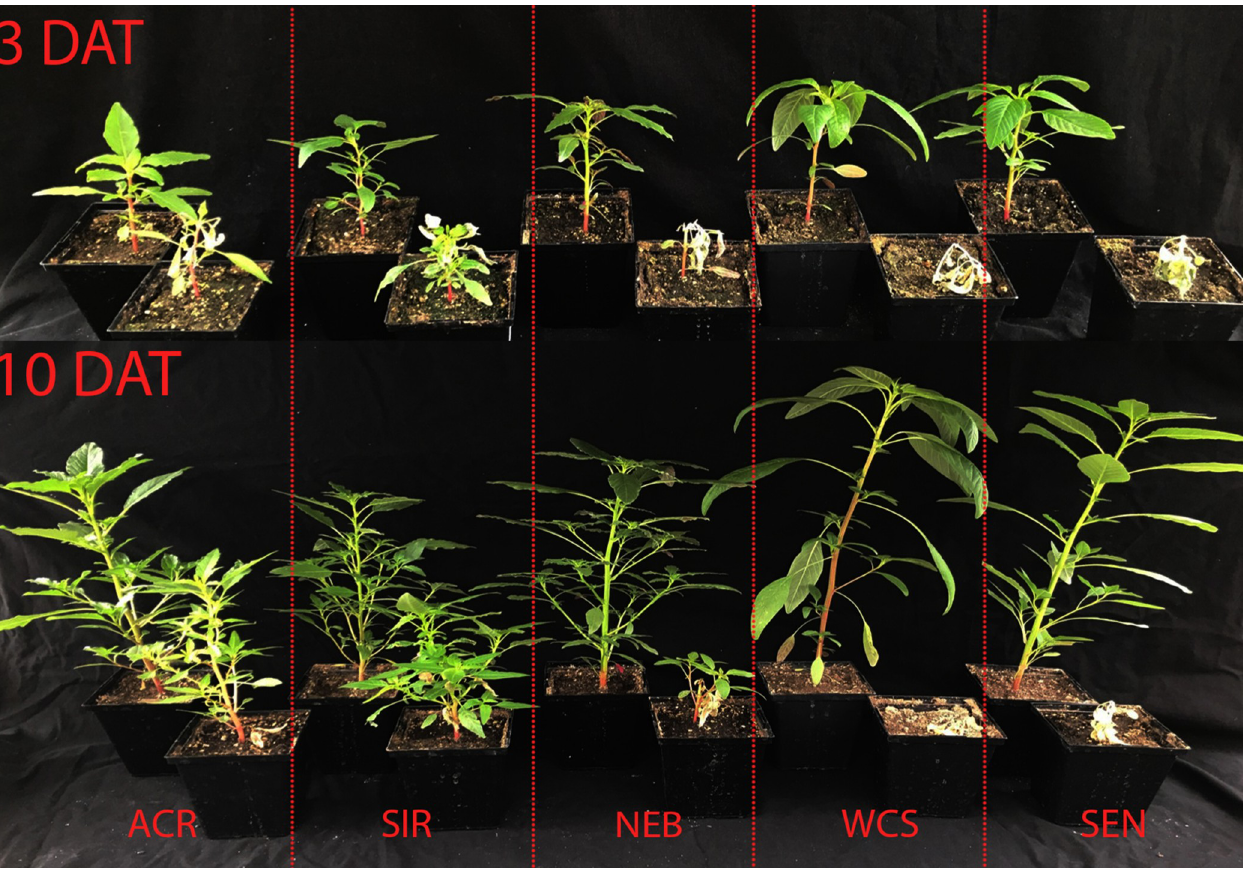
Fig 1. Waterhemp populations treated with a field-use rate of carfentrazone-ethyl (CE). Plants in the front row of the 3 and 10 DAT pictures were treated with 14 g ai ha -1 of CE (plus adjuvants) when seedlings were 9–11 cm tall. The corresponding nontreated controls for each population are positioned to the back-left of treated